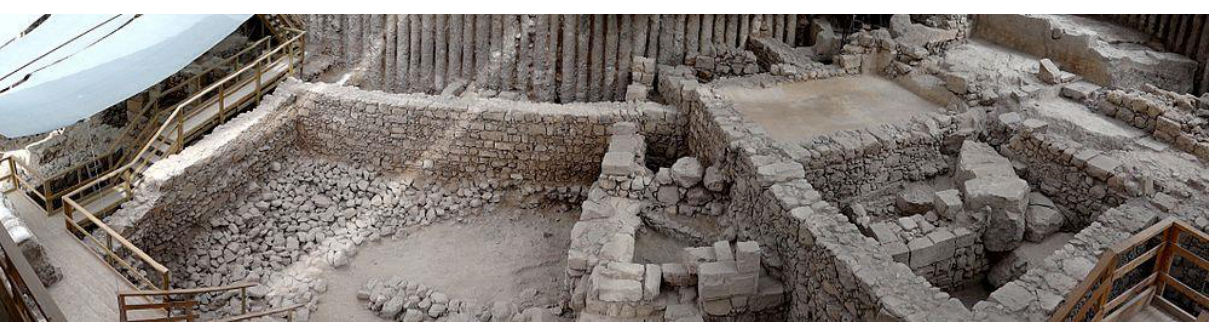
Figure 1: Givati Parking Excavation, Jerusalem, Panoramic View (source